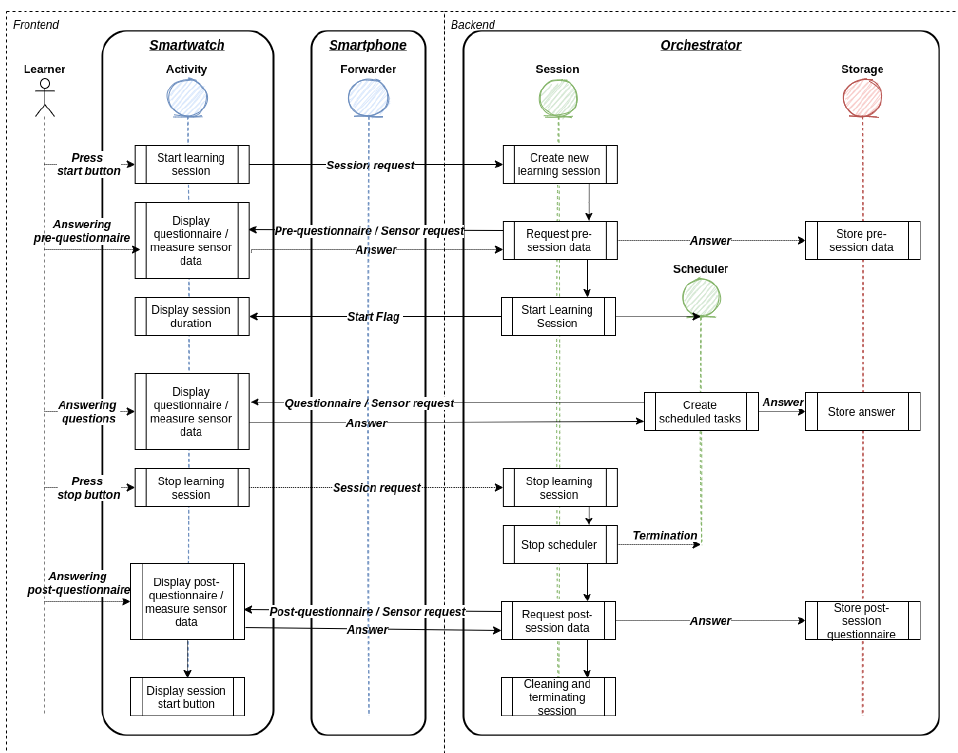
Figure 3. This figure displays the data orchestration of Edutex in the exploratory mode. Study designers can collect sensor and self-reported data before, within, and after the student started a learning session.